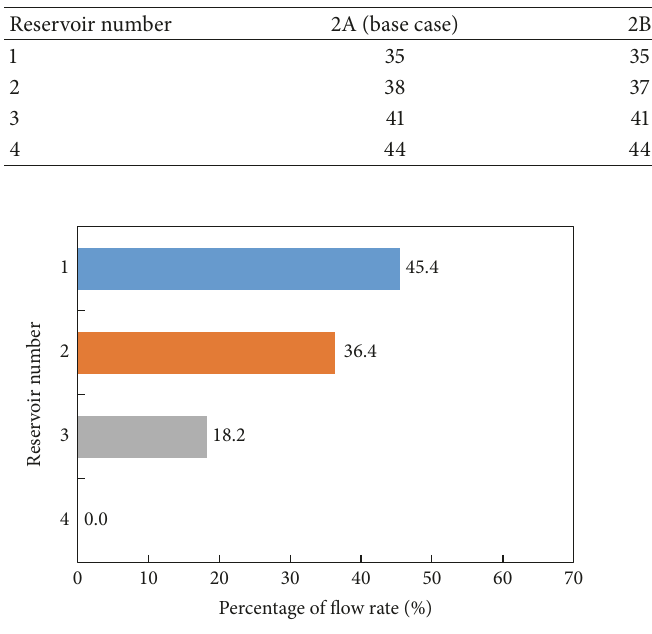
Figure 5: Flow-rate distribution of a conceptual model with the corresponding parameters of the formations in Table 3; the injection pressure, flow, and temperature are 10MPa, 4kg/s, and − 5 ∘ C, respectively.